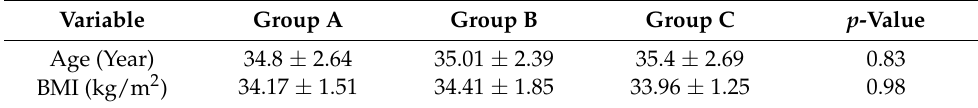
Table 1. Basic characteristics of participated patients of groups A, B, and C. Variable